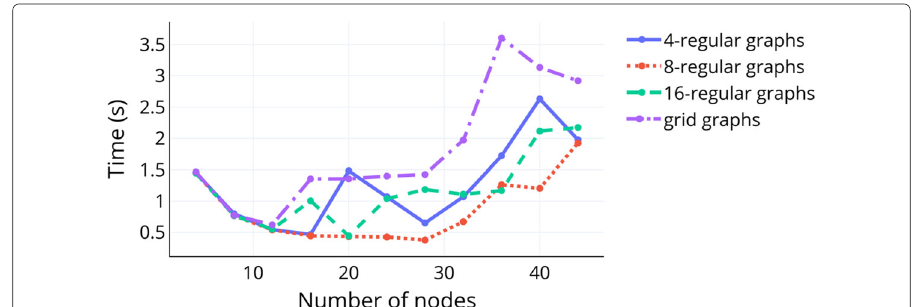
Fig. 2 Comparing the execution time using regular and grid graphs, Conll data set, for